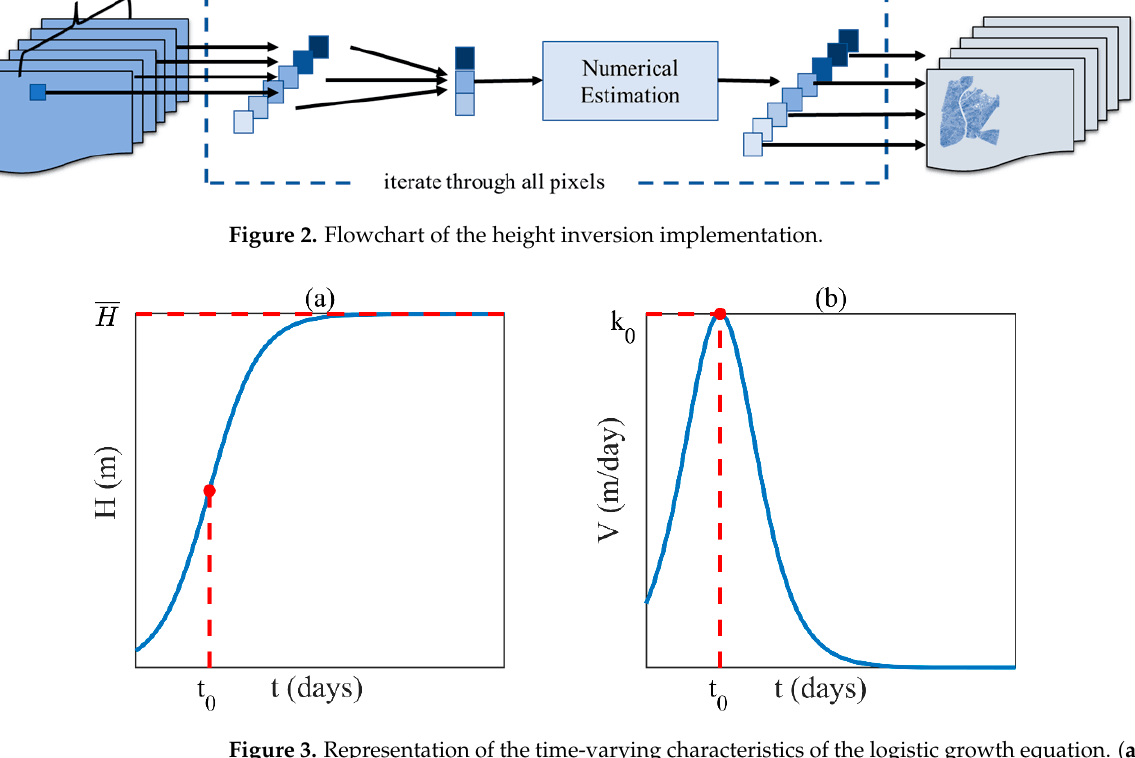
Figure 3. Representation of the time-varying characteristics of the logistic growth equation. ( a ) Graph of the rice crop height over time. ( b ) The variation in growth rate over time.